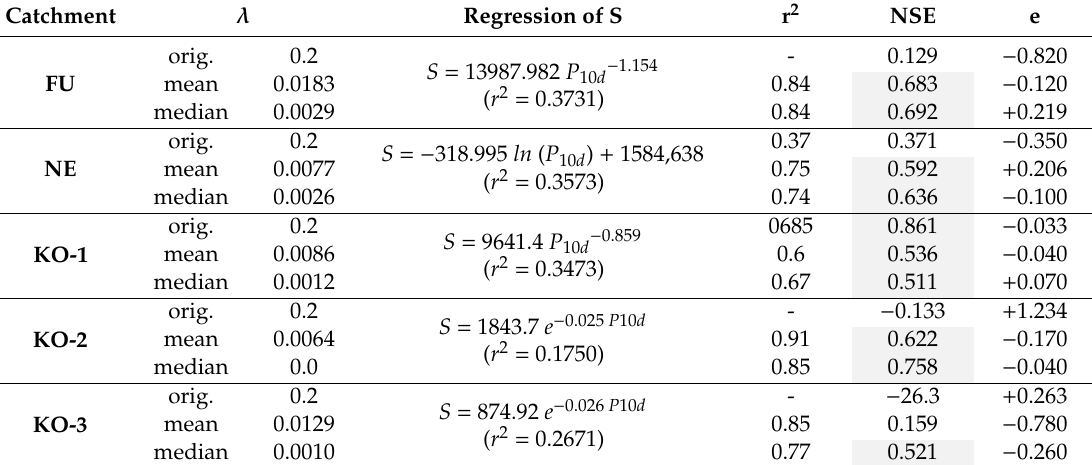
Table 8. Accuracy of direct runo ff simulations using regressions of S according to P 10 d (event analysis) in the experimental catchments using λ = 0.2, mean and median λ . NSE ≥ 0.500 indicating su ffi cient accuracy are highlighted.